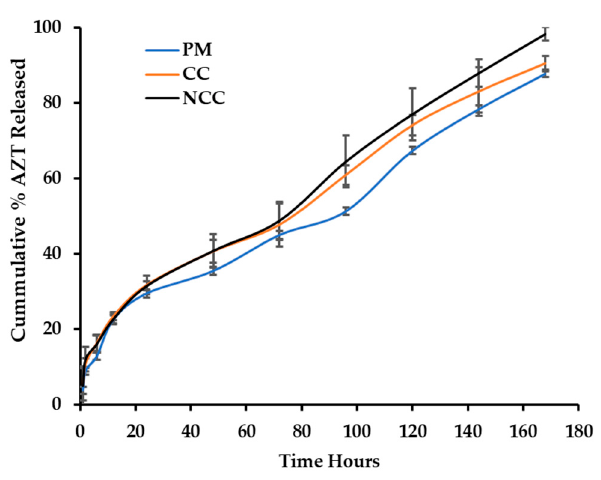
Figure 3. Cumulative percentage of zidovudine (AZT) released from a PF-127 hydrogel loaded with AZT in a physical mixture (PM), as micro co-crystal (MCC) and nano co-crystal (NCC).